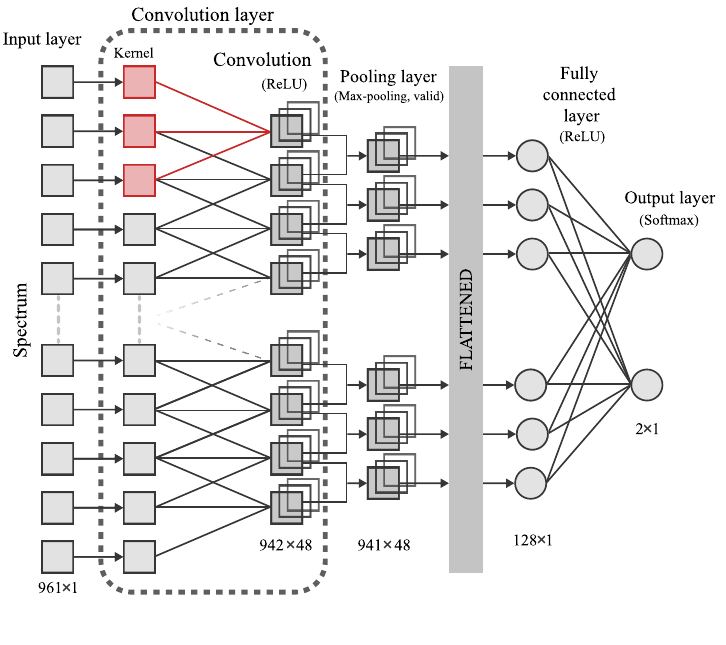
Figure 4. Scheme of the shallow Convolutional Neural Network used in this